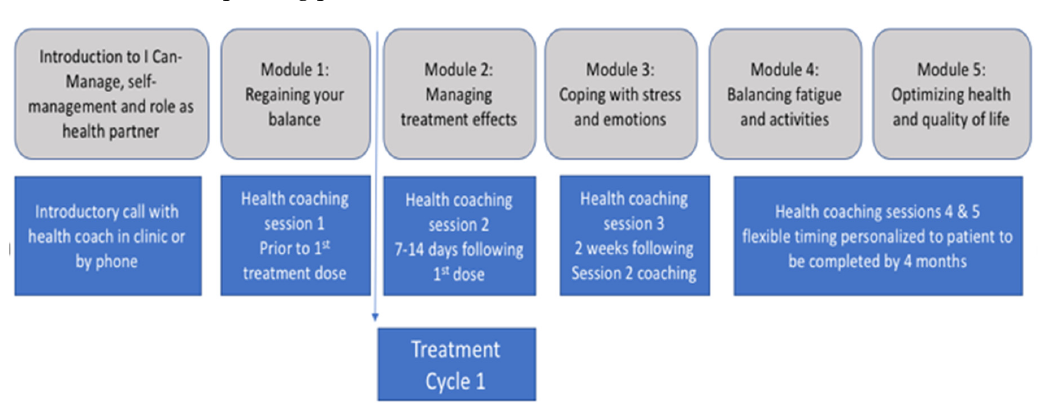
Figure 1. SMARTCare intervention timed across the treatment trajectory.